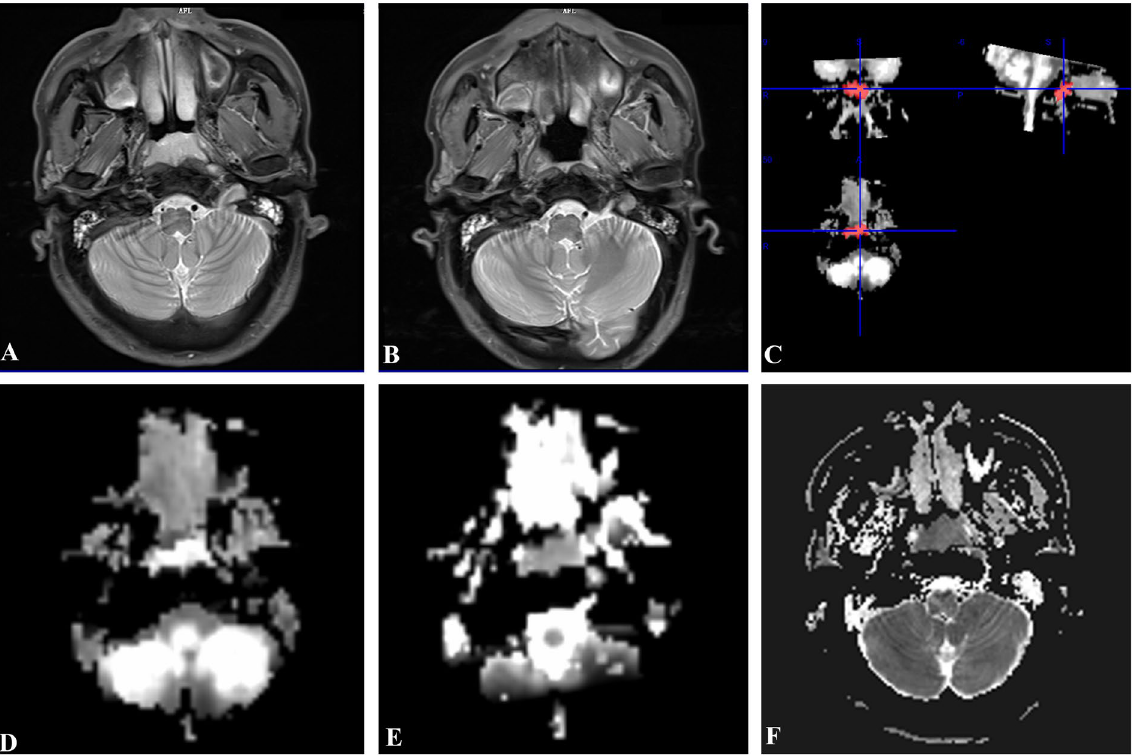
Figure 1. A 48-year-old man with NPC in RG. Pre-treatment PdWI ( A ) showed the lesion located at the bilateral mucous membrane of the nasopharynx. No residual tumor was detected on axis PdWI after radiotherapy ( B ). 3D-ROI were manual drawing including the whole lesion on Kmean map ( C ). The Dmean ( D ) and Kmean( E ) values were 1.36 × 10 − 3 mm 2 /s and 0.7 before treatment, respectively. The ADC min ( F ) was 726.1 × 10 − 3 mm 2 /s before